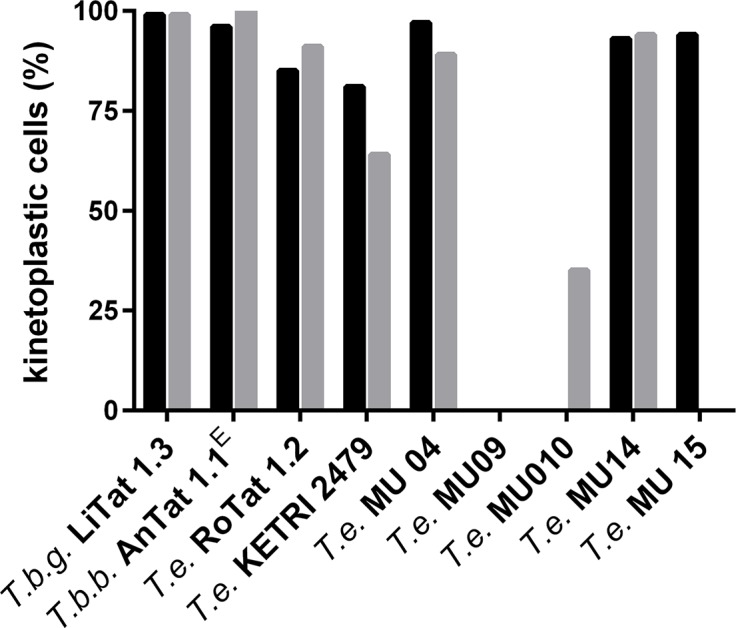
Percentage of kinetoplastic cells within T. evansi populations.Percentage of kinetoplastic cells visualised after DAPI staining and fluorescence microscopy within populations after 30 (black bars) and 60 days (grey bars) in vitro propagation. T.b.g. = T.b. gambiense, T.b.b. = T.b. brucei, T.e = T. evansi, MU = MCAM/ET/2013/MU.